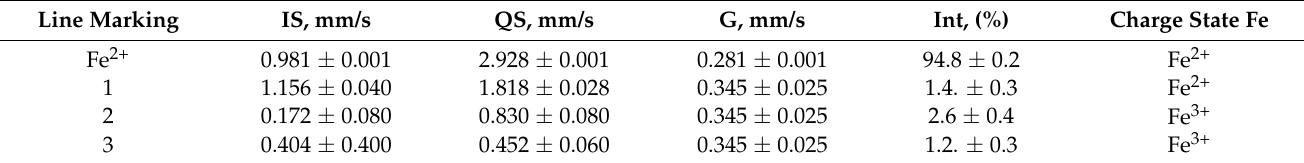
Table 4. Parameters of hyperfine interactions obtained by mathematical processing of Mössbauer